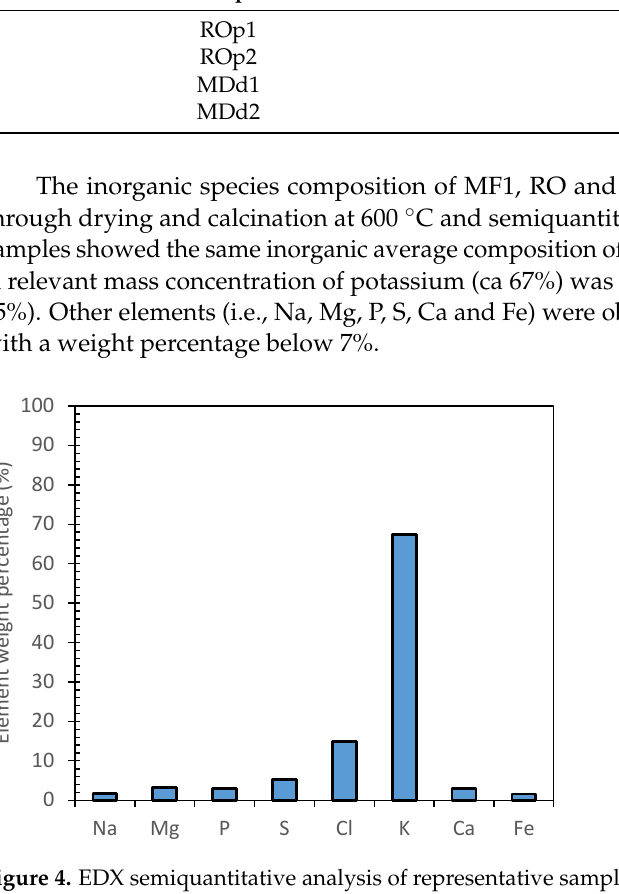
Figure 4. EDX semiquantitative analysis of representative sample.